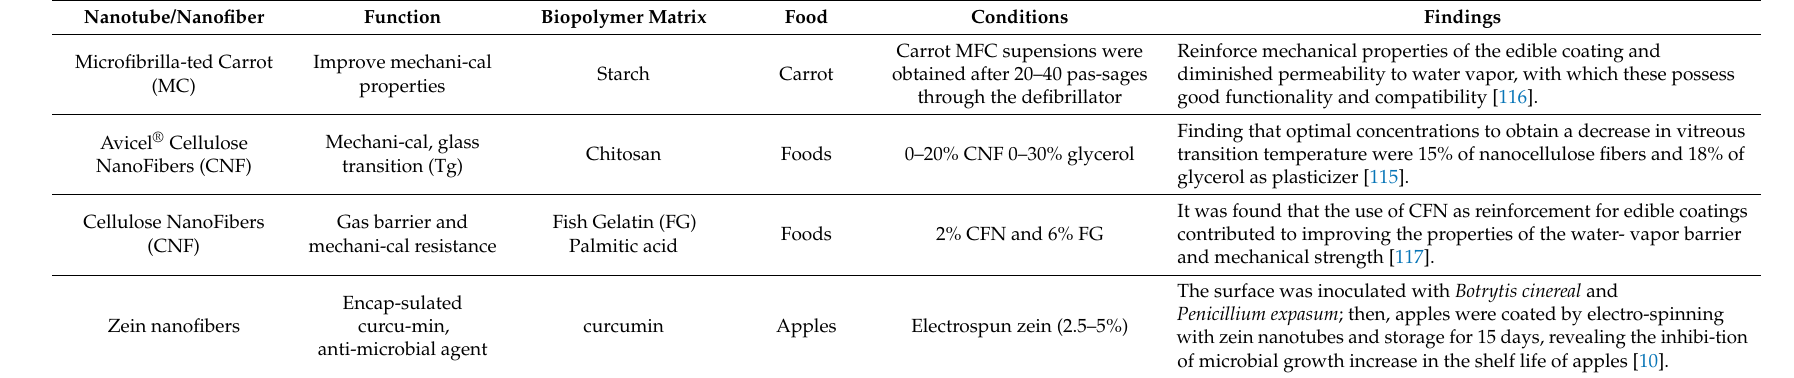
Table 5. Nanofibers and nanotubes utilized in edible